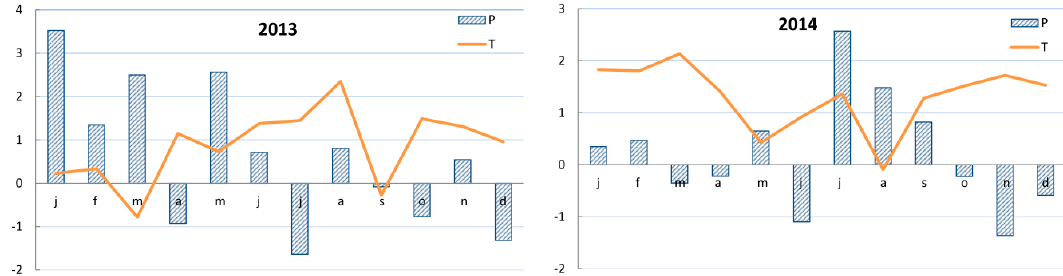
Figure 3. Temperature and precipitation anomalies standardised with respect to the 1901–2014 mean and expressed in standard deviation units, where P is the monthly precipitation sum, and T is the mean monthly temperature).